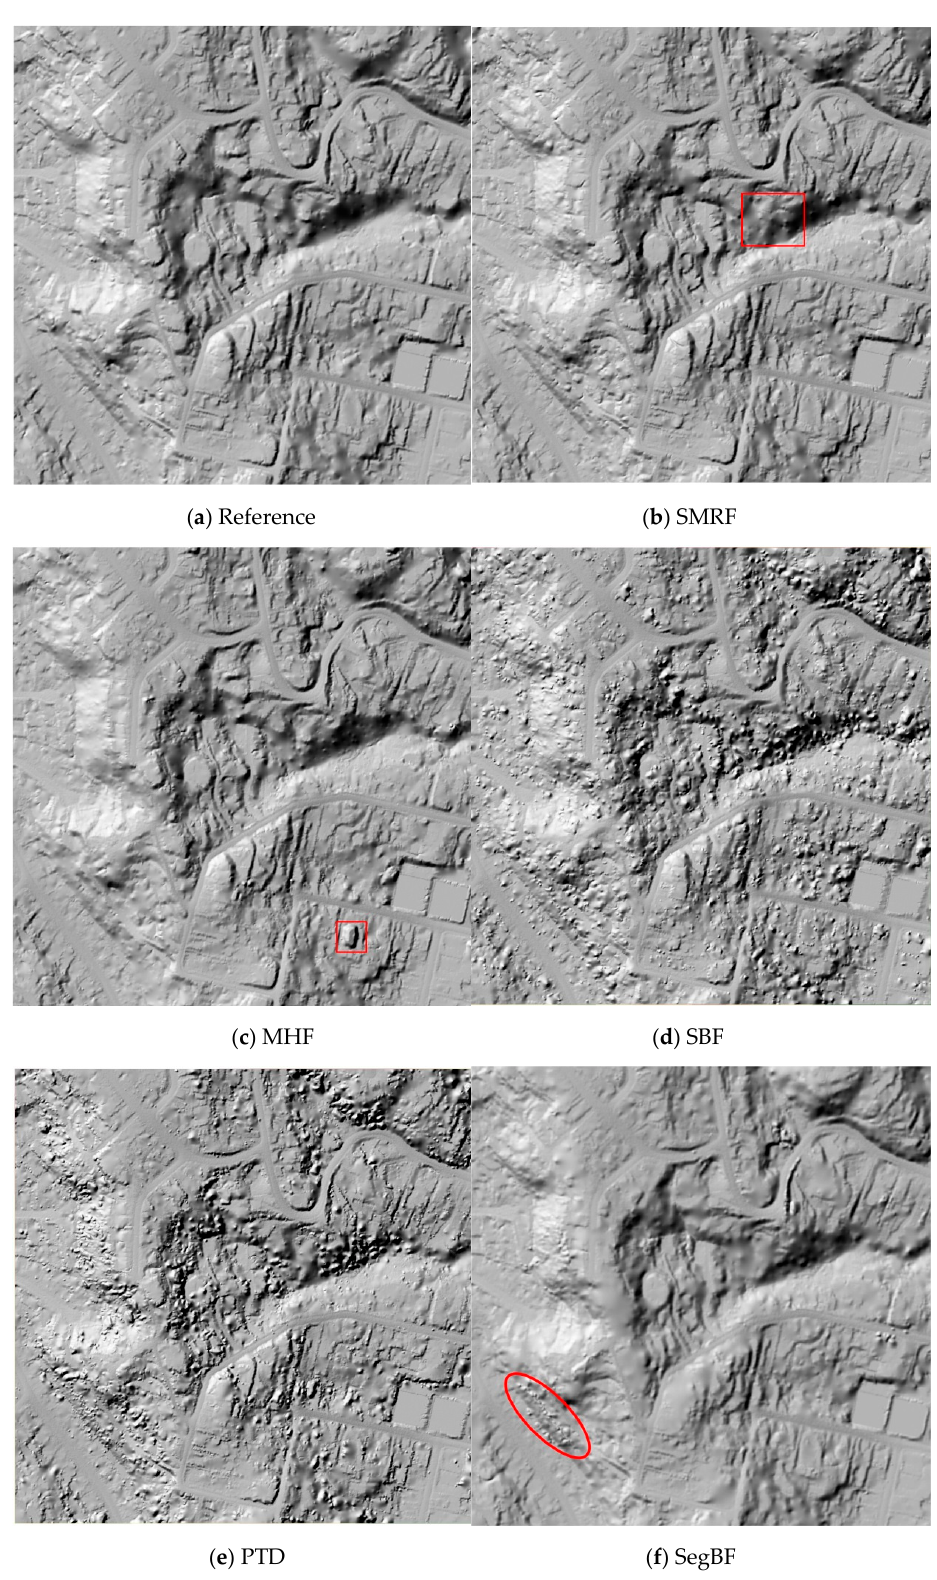
Figure 11. Reference DEM and the DEMs of all the filtering algorithms on plot 2: ( a ) Reference DEM, ( b ) SMRF, ( c ) MHF, ( d ) SBF, ( e ) PTD and ( f )